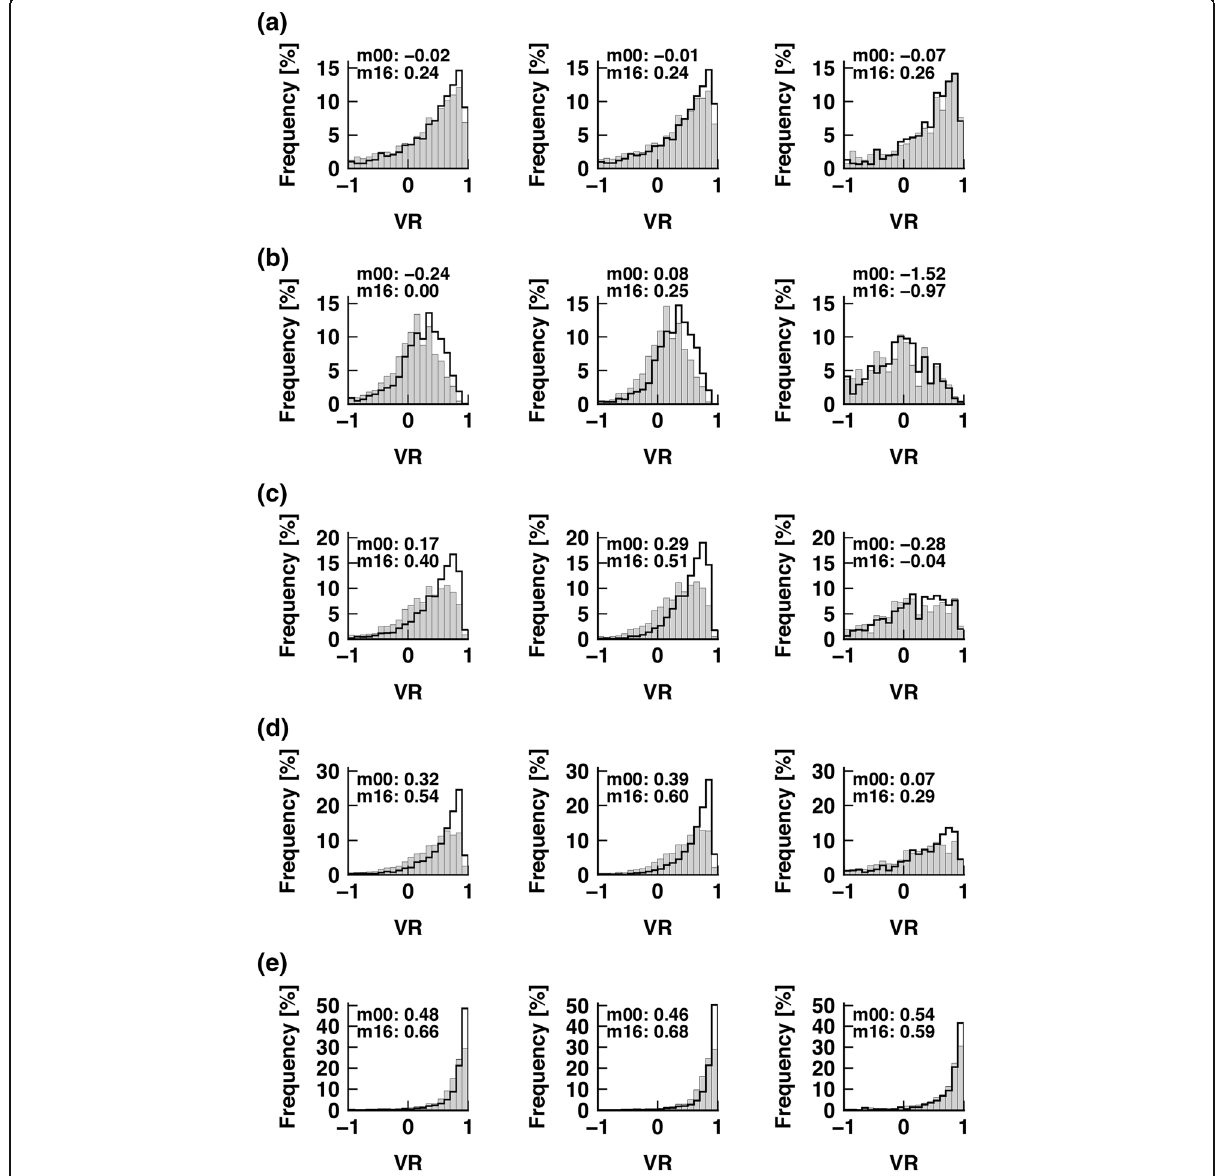
Fig. 6 Histograms of the variance reduction VR for the initial and final models m 00 and m 16 . a All windows for the period range of 5 – 30 s. b Full waveform for the period range of 5 – 30 s. c Full waveform for the period range of 8 – 30 s. d Full waveform for the period of 10 – 30 s. e Full waveform for the period range of 20 – 30 s. The left, center, and right panels show all events, events that occurred at depths greater than 30 km, and events that occurred at depths less than 30 km, respectively. The gray bars and black outlines represent the VR values of m 00 and m 16 , respectively. The VR values can range from −∞ to 1. The average VR values are also shown in each